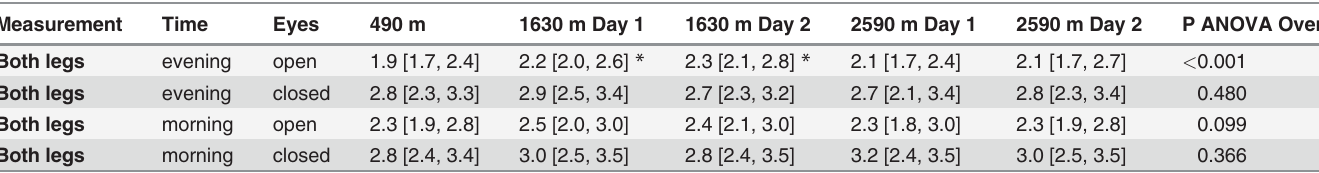
Table 3. Anterior-posterior sway amplitude at different altitudes.